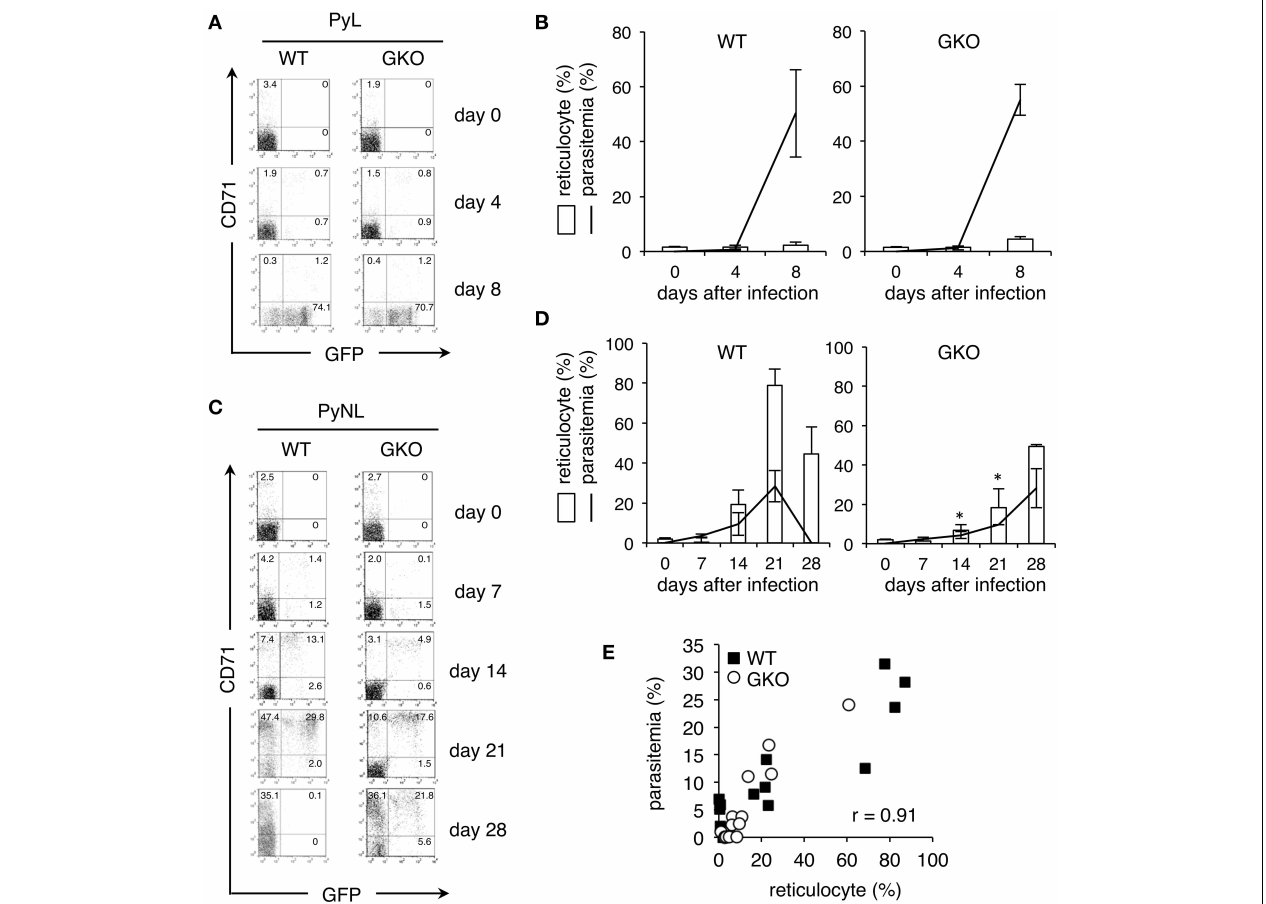
the indicated days after infection (B,D) . Values represent mean ± standard deviation from five mice. Asterisks denote statistical significance at p < 0 . 05 using Student’s t -test compared with WT mice. (E) The percentages of parasitemia and the percentages of reticulocytes in peripheral blood from WT (closed squares) and GKO (open circles) mice infected with PyNL were plotted, and the correlation coefficient was calculated. The data used for this plot are from individual WT and GKO mice showing parasitemia during days 7–28 post-infection. Similar results were obtained from three repeats of the